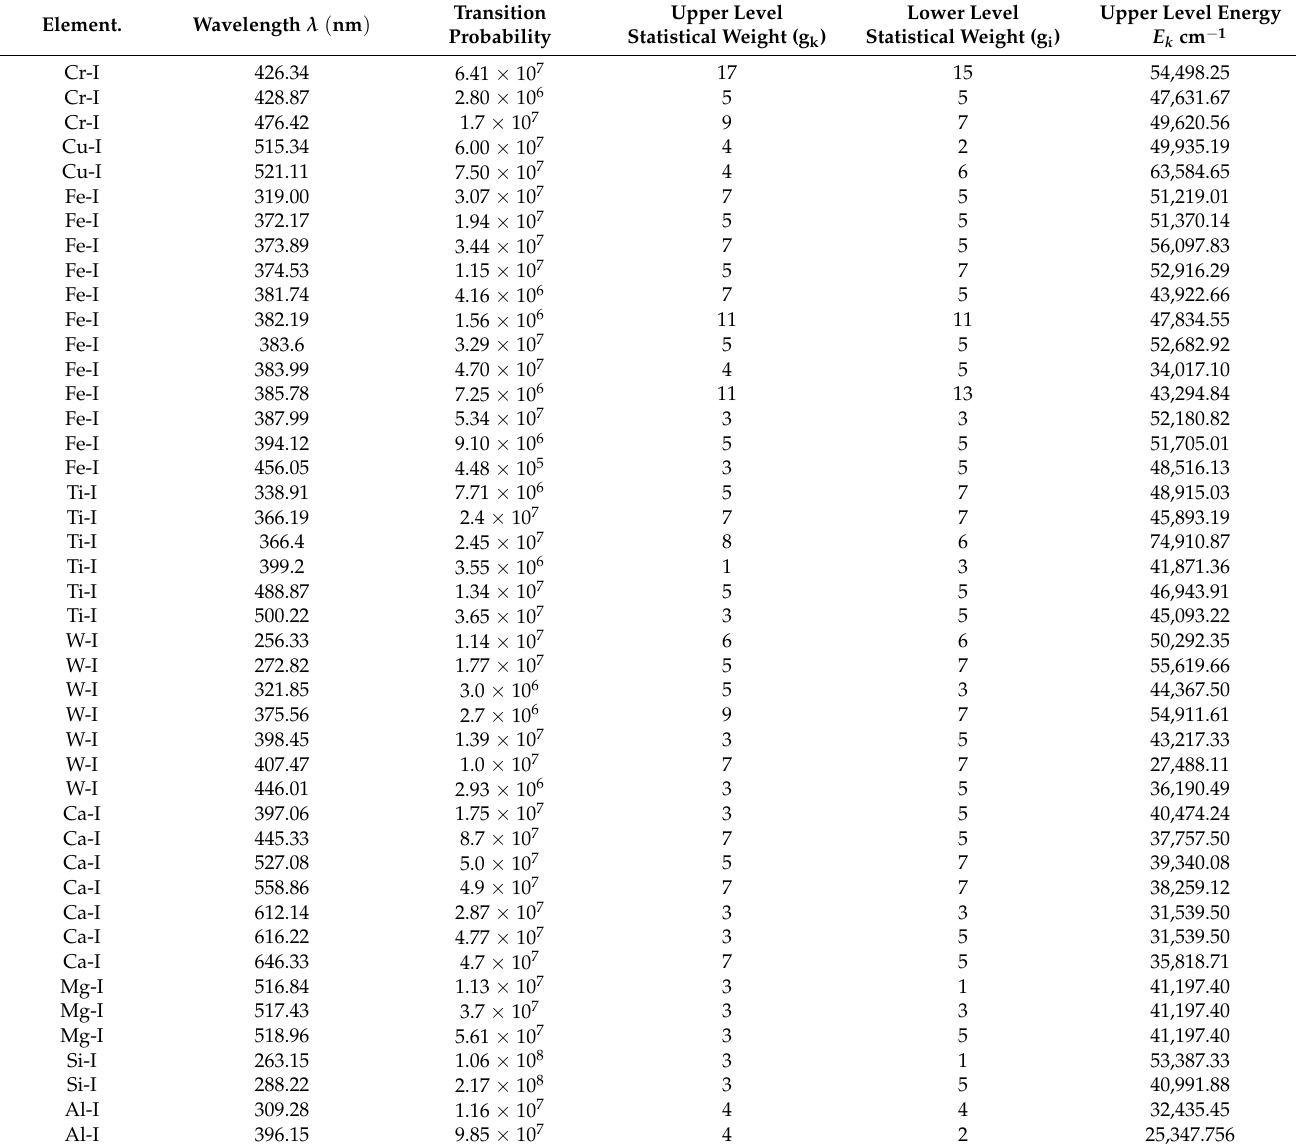
Table 4. Spectroscopic parameters of selected emission lines of different compositional elements of astrophyllite sample used for calibration-free analysis.